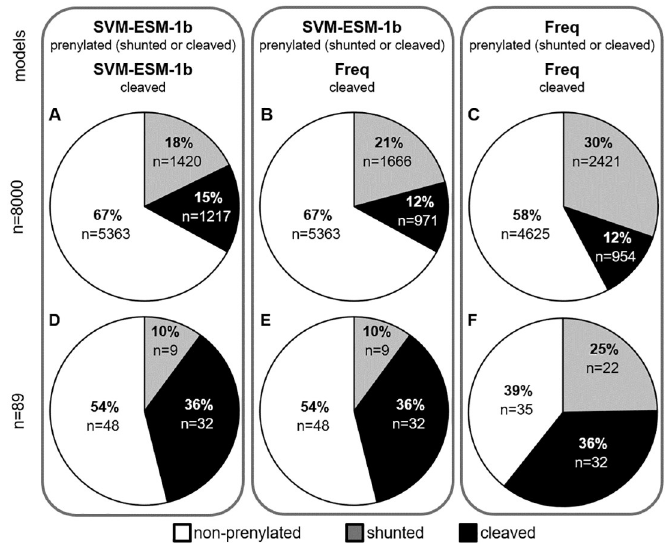
Fig 5. Predictions for modification of Cxxx sequences based on various methods. Predictions for prenylation and cleavage for all 8000 Cxxx sequences (A-C) and 89 naturally occurring yeast Cxxx sequences (D-F). Models used for prenylation prediction were SVM-ESM-1b (A,B,D,E) and the in-house, frequency-based method (C,F). Models used for cleavage prediction were SVM-ESM-1b (A,D) and the in-house, frequency-based method (B,C,E,F). Predictions are binned as non-prenylated (white), shunted (gray), and cleaved sequences (black). Cleaved sequences have a prerequisite of being prenylated by the indicated prediction model.